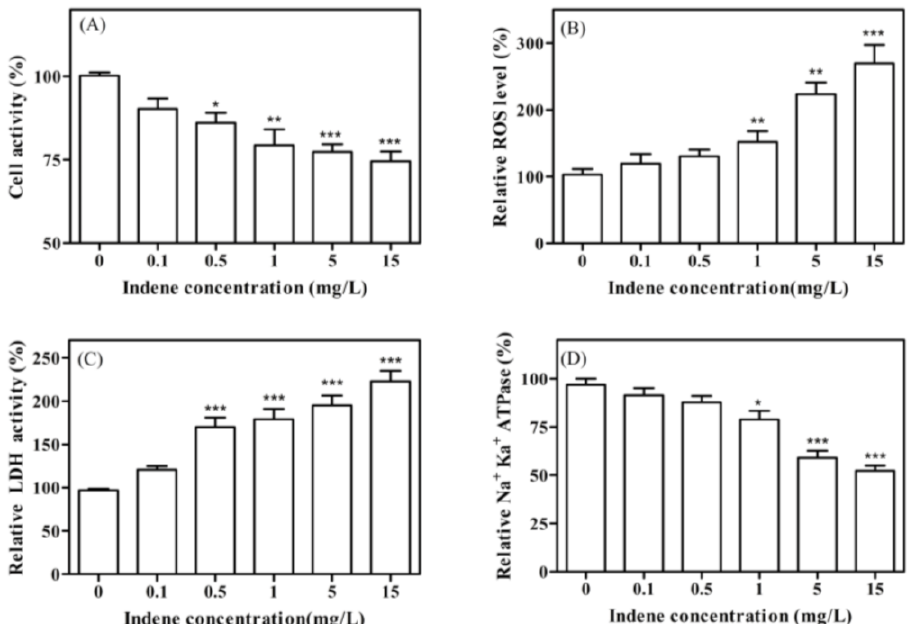
Figure 1. Relative cell viability ( A ), ROS ( B ), LDH ( C ) and Na + K + ATPase activity ( D ) after 24 h IND exposure. Values are means ± SEM ( n = 3). Differences are considered statistically significant at p < 0.05, p < 0.01 and p < 0.001 and labeled with * and ** and ***,